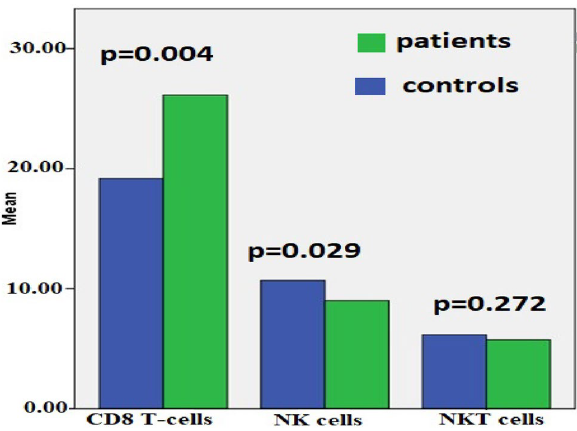
Figure 2. Percentages of CD 8, NK and NKT cells in patients versus control.